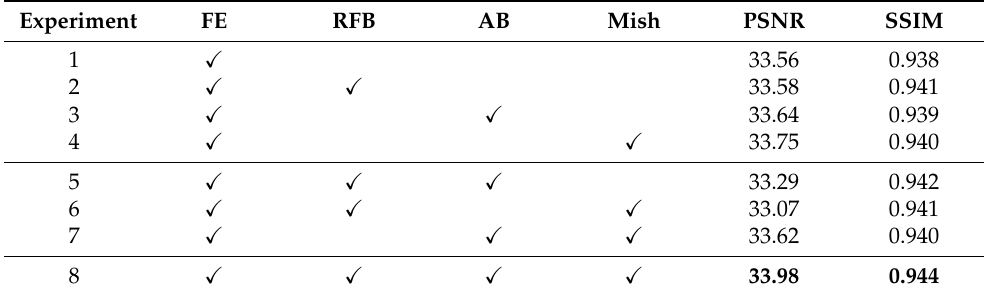
Table 3. Grid search results for multiple techniques. The best quantitative results are marked in